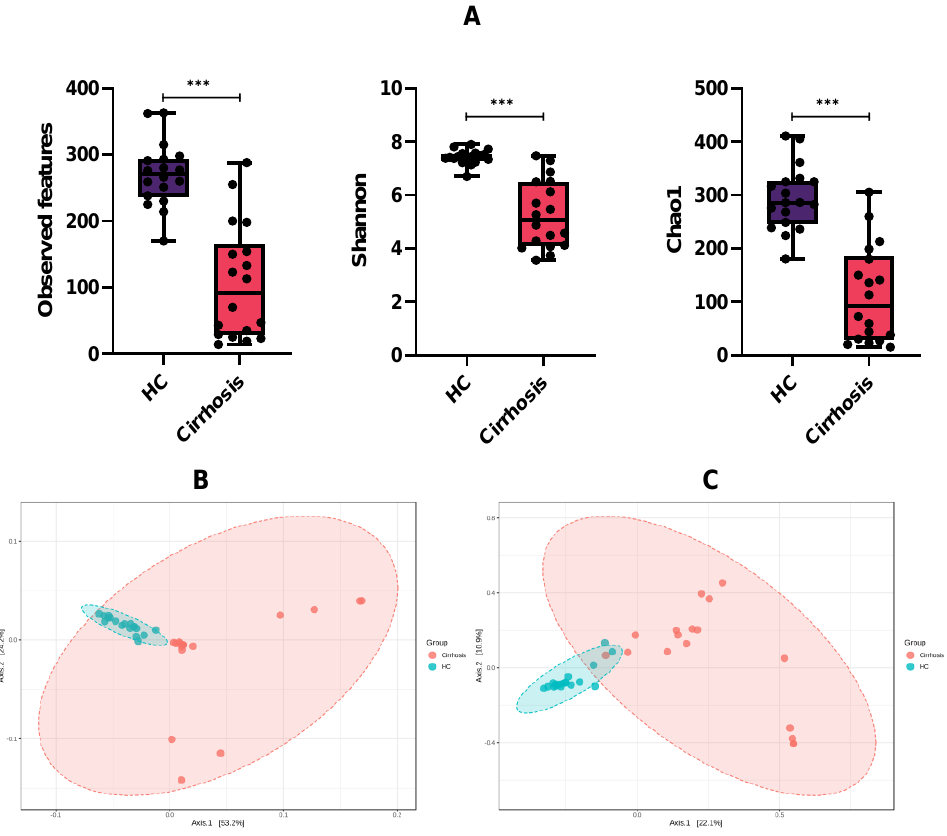
Figure 1. Microbiota richness and diversity. ( A ) Alpha diversity indices: Observed features, Shannon and Chao1 indices of healthy controls group compared with patients with cirrhosis. Mann-Whitney U test, *** p < 0.001; ( B ) Beta diversity plots for weighted and unweighted ( C ) UniFrac distances in cirrhosis group (red) and healthy control group (HC, blue). PERMANOVA tested, p < 0.001 in both cases.